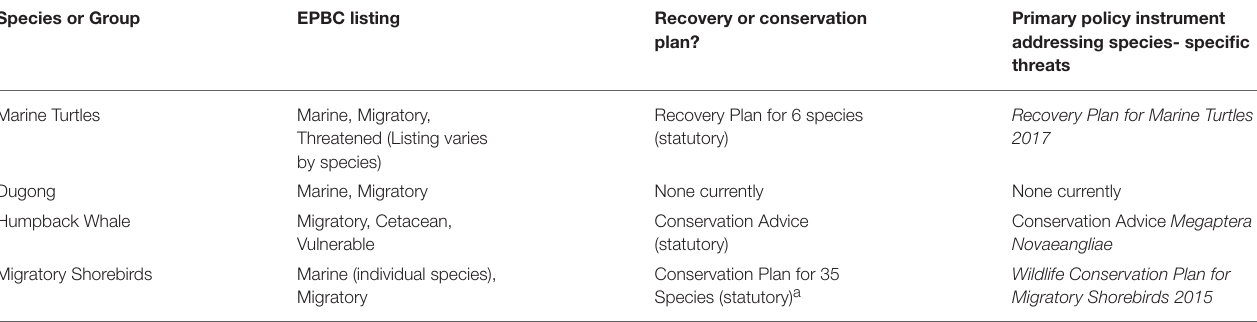
TABLE 1 | The EPBC listing of the four case studies in Australia chosen for this study, their respective national management plans, and the primary species-specific instrument (national) for mitigating threats for each case study. Species or Group